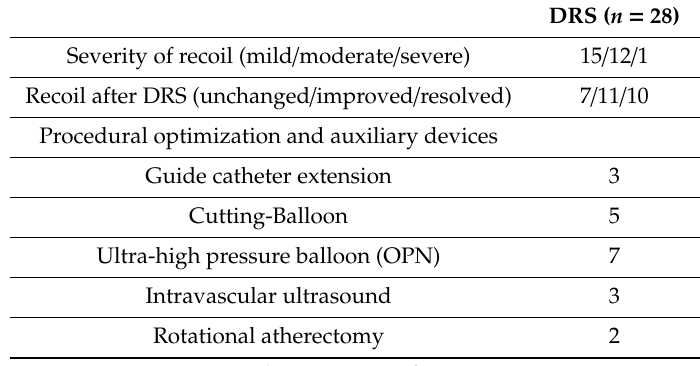
Table 2. Procedural Characteristics of Patients with Stent Recoil.